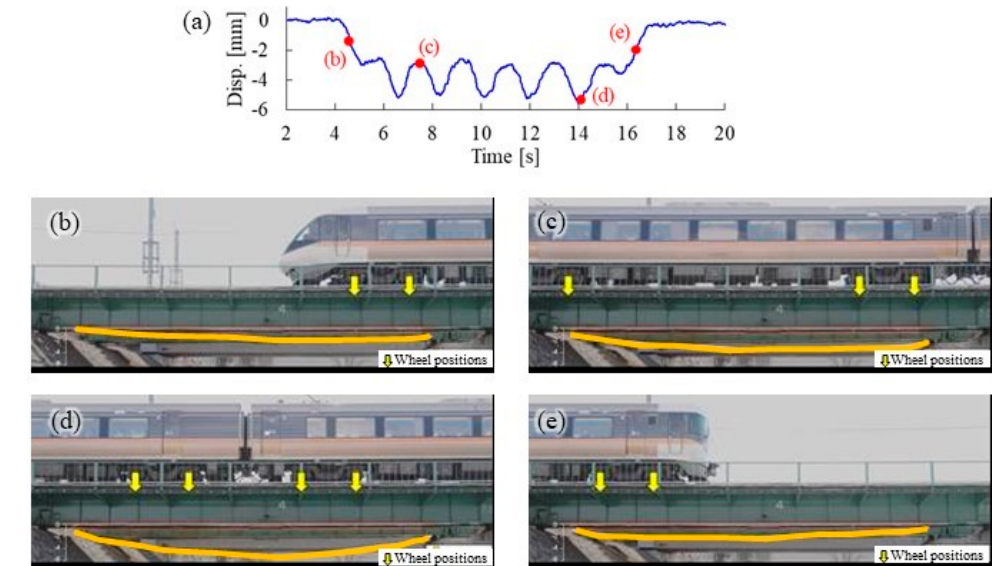
Figure 20. Estimated results of bridge deflection shape by non-marker image measurement: ( a ) dis- placement response at the bridge midspan, and bridge displacement when ( b ) the train is entering, ( c , d ) the train is passing, and ( e ) the train is exiting.